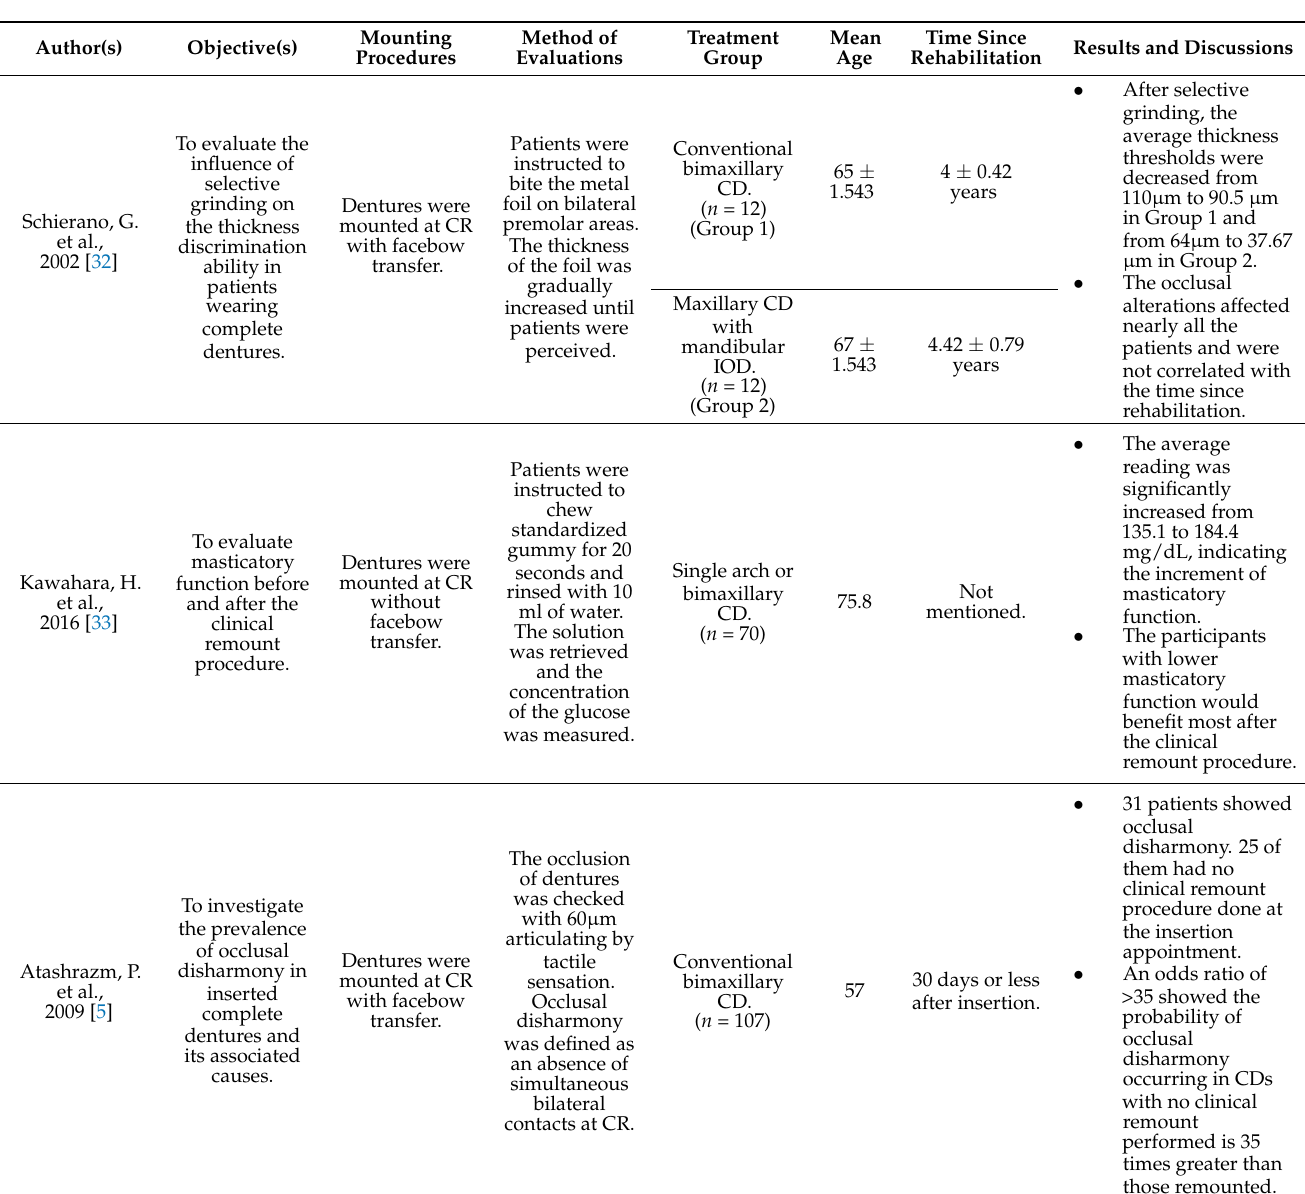
Table 3. The current research works about performing clinical remount on existing dentures were listed and compared. (CR: Centric relation; CD: Complete denture; IOD: Implant-supported overden- ture)